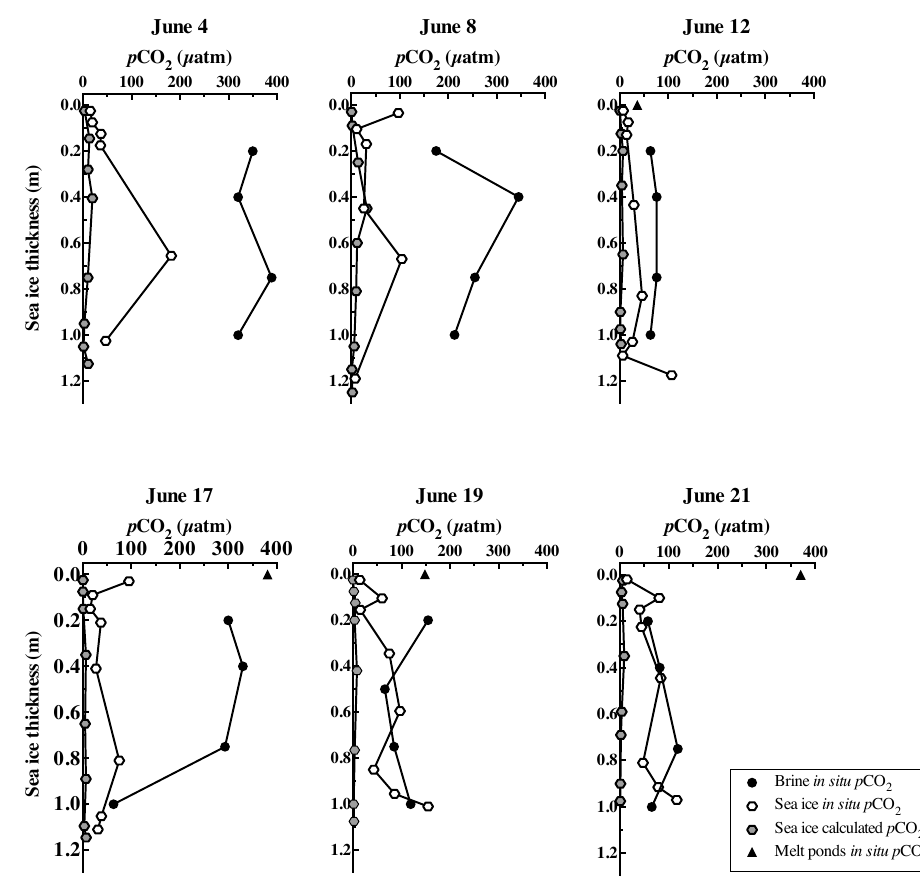
Figure 4. Profiles of sea ice p CO 2 [bulk_calc] (calculated from TA ice and TCO 2ice , grey hexagons), sea ice p CO 2 [bulk] (white hexagons), brine and melt ponds p CO 2 [in situ] (black dots and triangles,